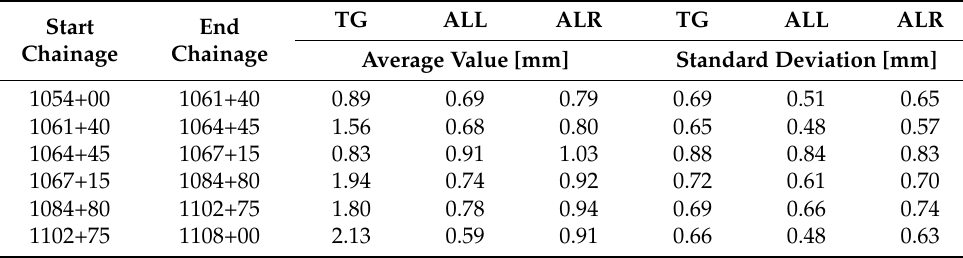
Table 5. Average and deviation of track parameters (section No. 4).